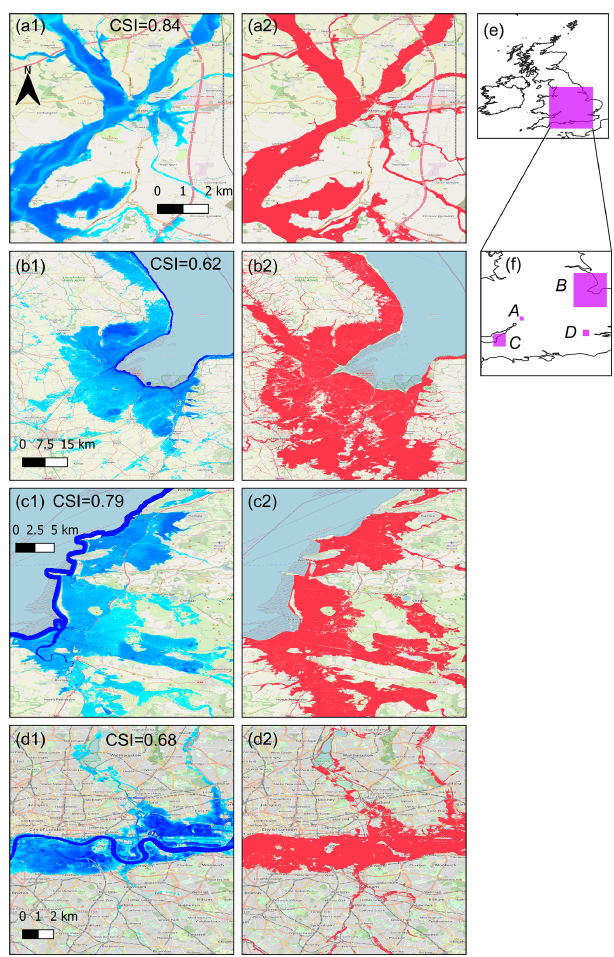
Figure 2. Comparison of fluvial and coastal hazard layers pro- duced by the national model developed in this paper (left-hand panels, labelled 1, in blue) to equivalent government flood haz- ard maps (right-hand panels, labelled 2, in red). Maps are shown for: (a) fluvial flooding surrounding Tewkesbury in Central Eng- land at the confluence of the Severn and Warwickshire Avon rivers; (b) predominantly coastal flooding around the area of the Wash tidal embayment in Eastern England; (c) coastal and river flooding in the Somerset Levels, Southwest England; and (d) tidal and fluvial flooding in London. Panels (e) and (f) show the location of the test sites within the UK. Values of the critical success index (CSI) per- formance metric (see Eq. 3 and Table 2) are given for each site. Base map data are © OpenStreetMap contributors 2022. Distributed un- der the Open Data Commons Open Database License (ODbL)